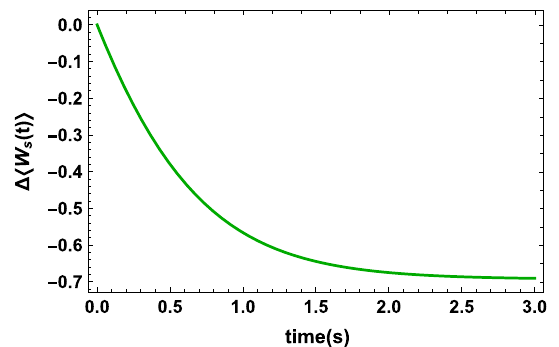
Figure 4. The work � (cid:31) W s ( t ) (cid:30) versus time t for a two-level system in contact with a thermal bath with decay rate γ( t ) = 0.2 s − 1 and ω 0 = 2 s − 1 . As can be seen work is done on the system by the bath through the interaction and as the system approaches equilibrium the bath stops doing work on the